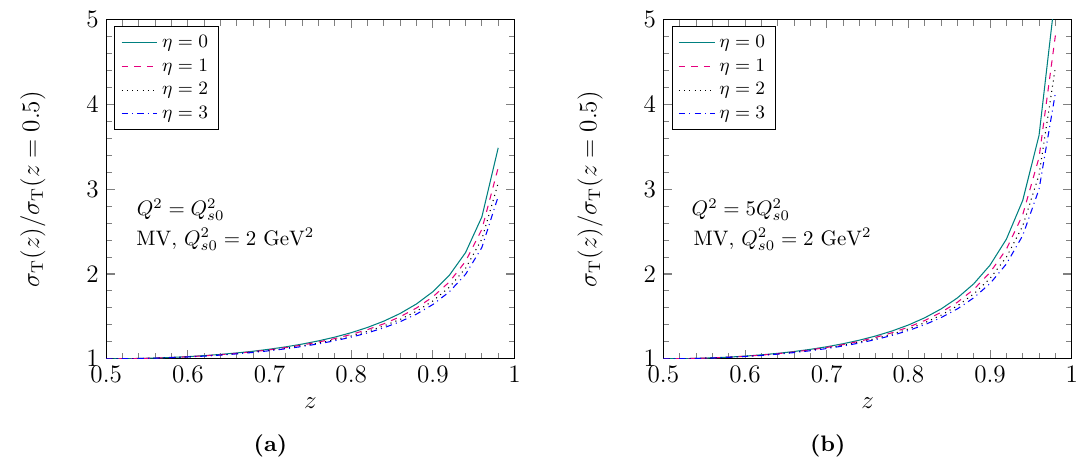
Figure 11. The normalized k -integrated transverse cross section-defined in eq. (4.11) plotted as a function of z for various values of η at (a) Q 2 = Q 2